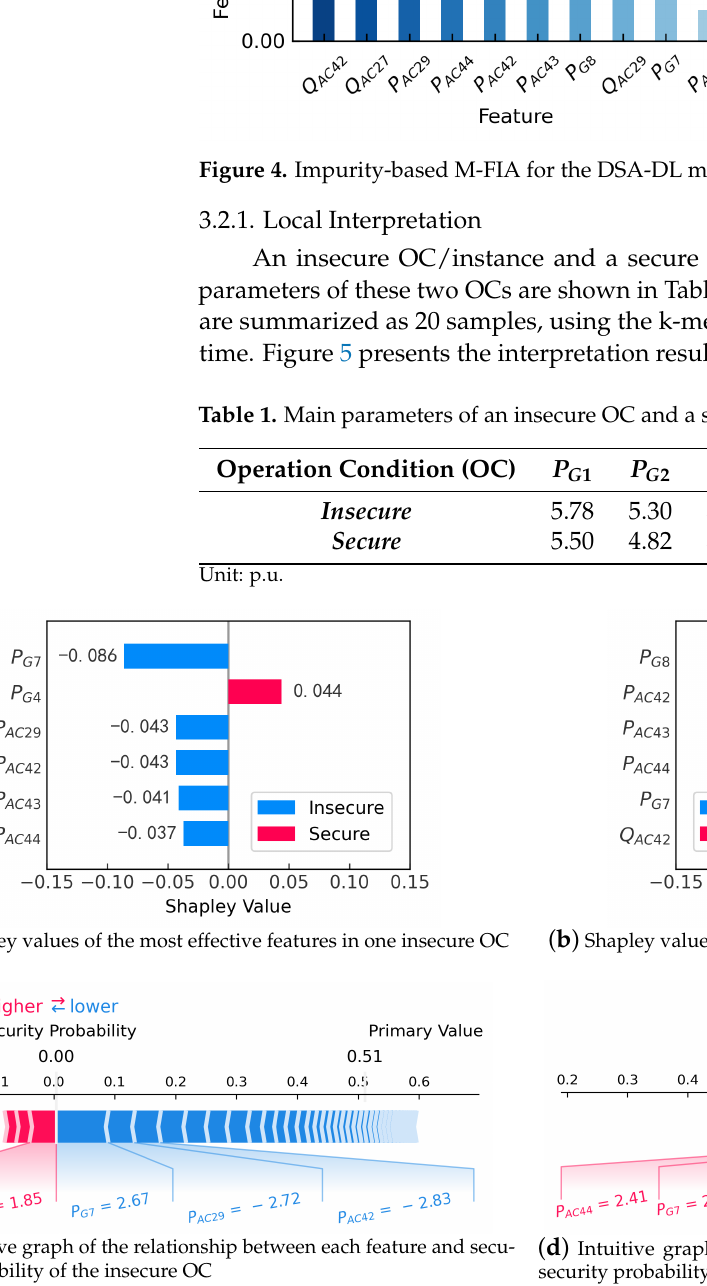
Figure 5. Local interpretation for one insecure OC and one secure OC from the perspective of feature importance. Note that the numerals beside bars in ( a , b ) are Shapley values of corresponding features, and the numerals under the bars in ( c , d ) are feature values in units of